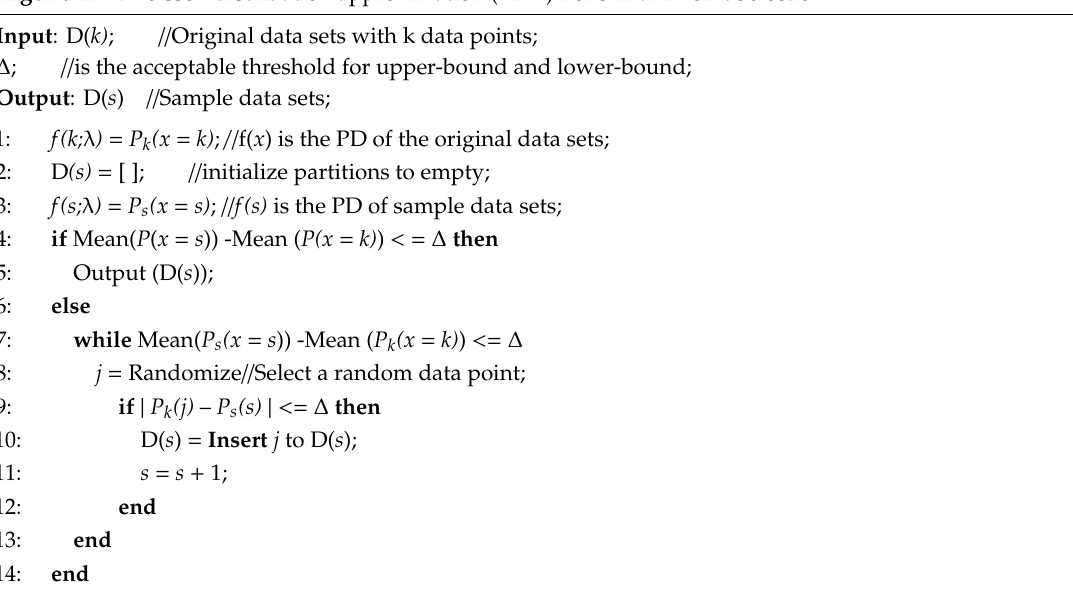
Algorithm 1. Poisson distribution approximation (PDA) Benchmark Point